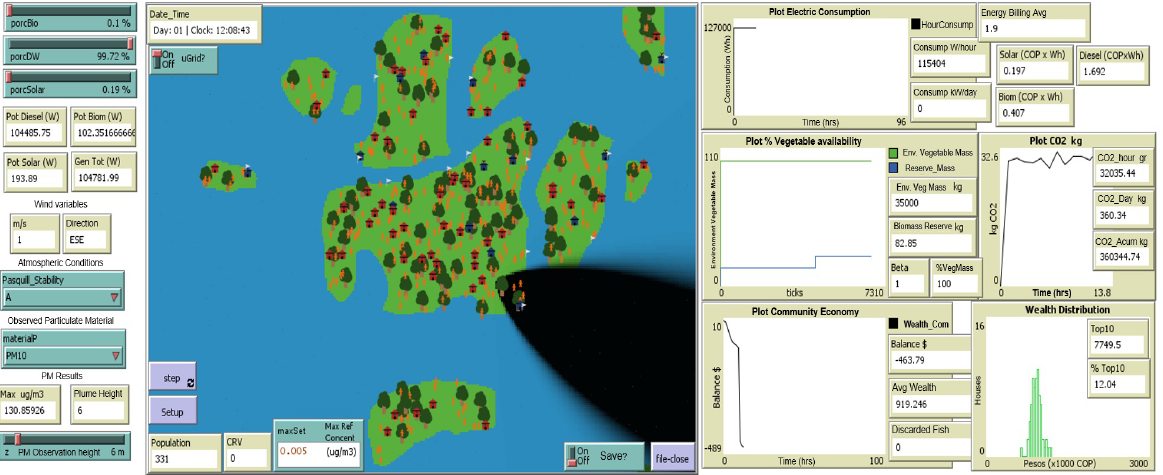
Figure 22. Online mode, 12 h of